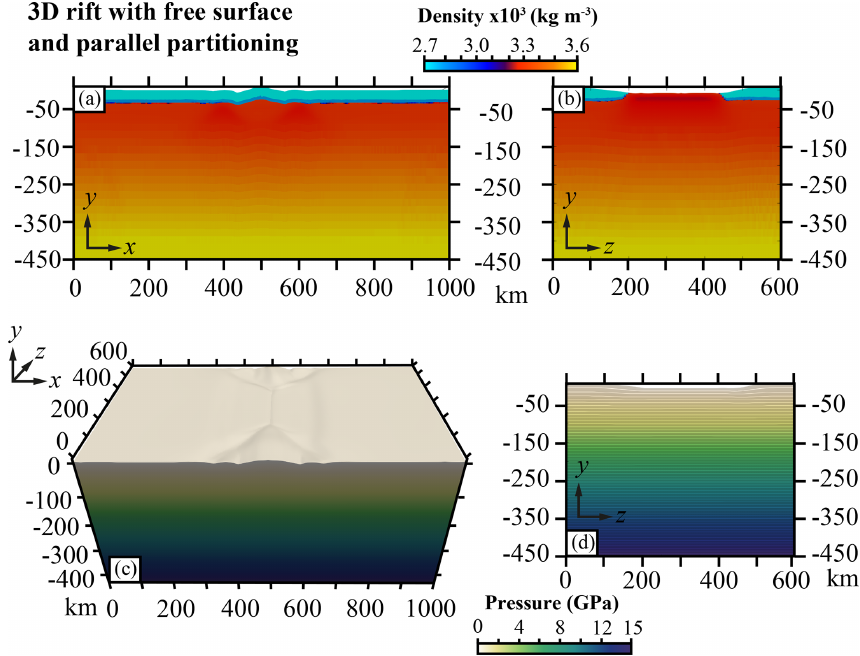
Figure 10. (a) Cross section showing the density of the 3D rift model with normal stress boundary conditions in the x – y plane at z = 0. (b) Cross section showing the density of the z – y plane at x = 500km. (c) 3D view of the pressure computed with Eq. (7). (d) Cross section of the z – y plane at x = 500km for the reference pressure. The contour lines are plotted every 0.25GPa.